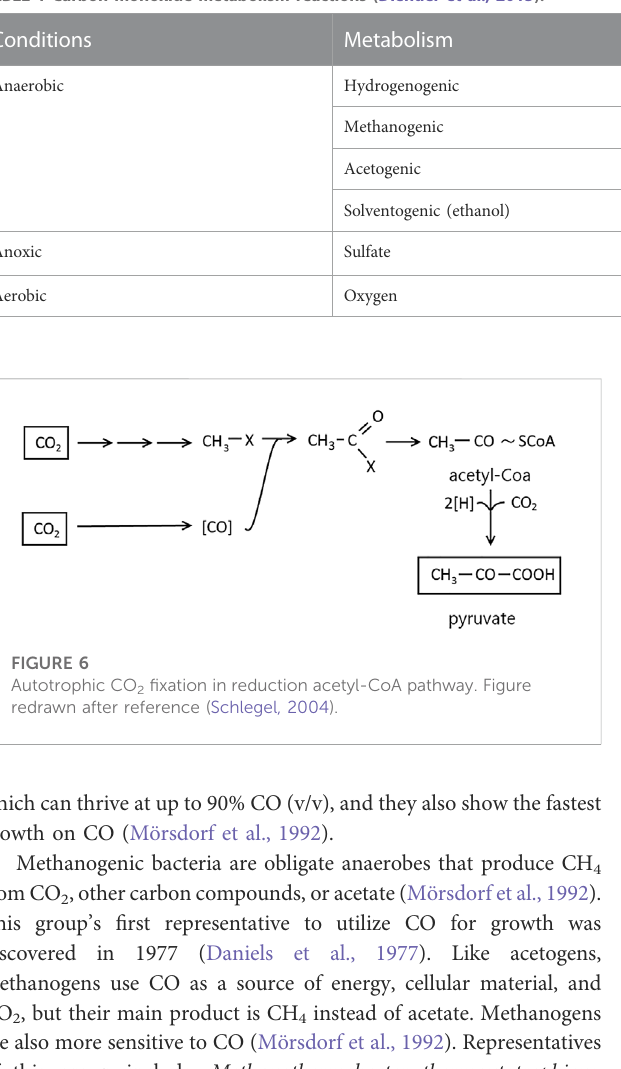
TABLE 1 Carbon monoxide metabolism reactions (Diender et al., 2015).